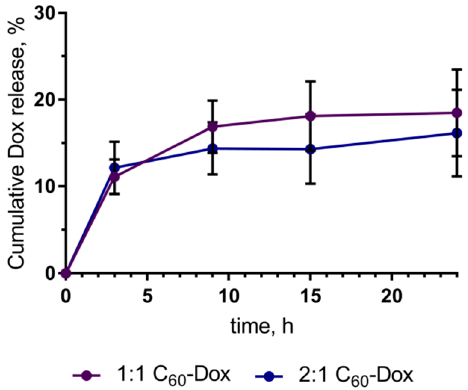
Figure 2. Dox release from C 60 -Dox nanocomplexes during 24 h of incubation in Roswell Park Memorial Institute (RPMI 1640) medium.